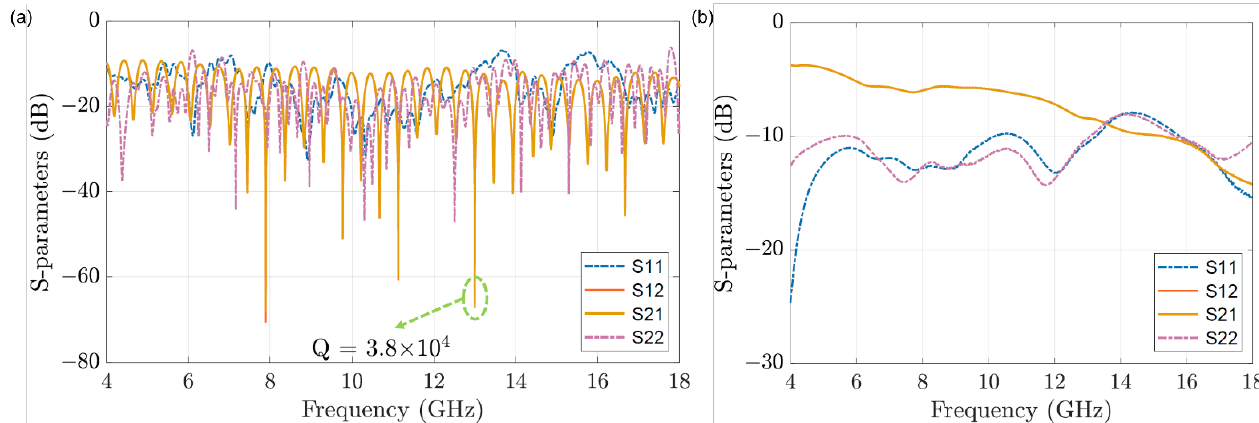
Figure 2. The S-parameters of ( a ) the measurement system of the proposed microwave interferometric cytometry and ( b ) the designed microfluidic sensor.